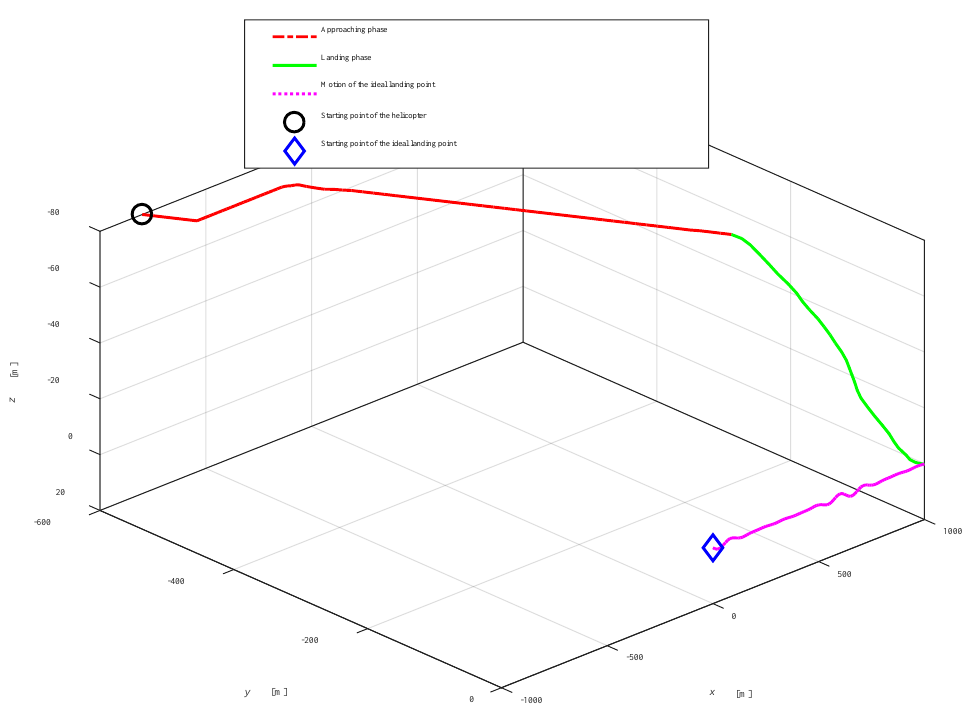
Figure 11. Landing path of the helicopter and 3D motion of the ideal landing point.